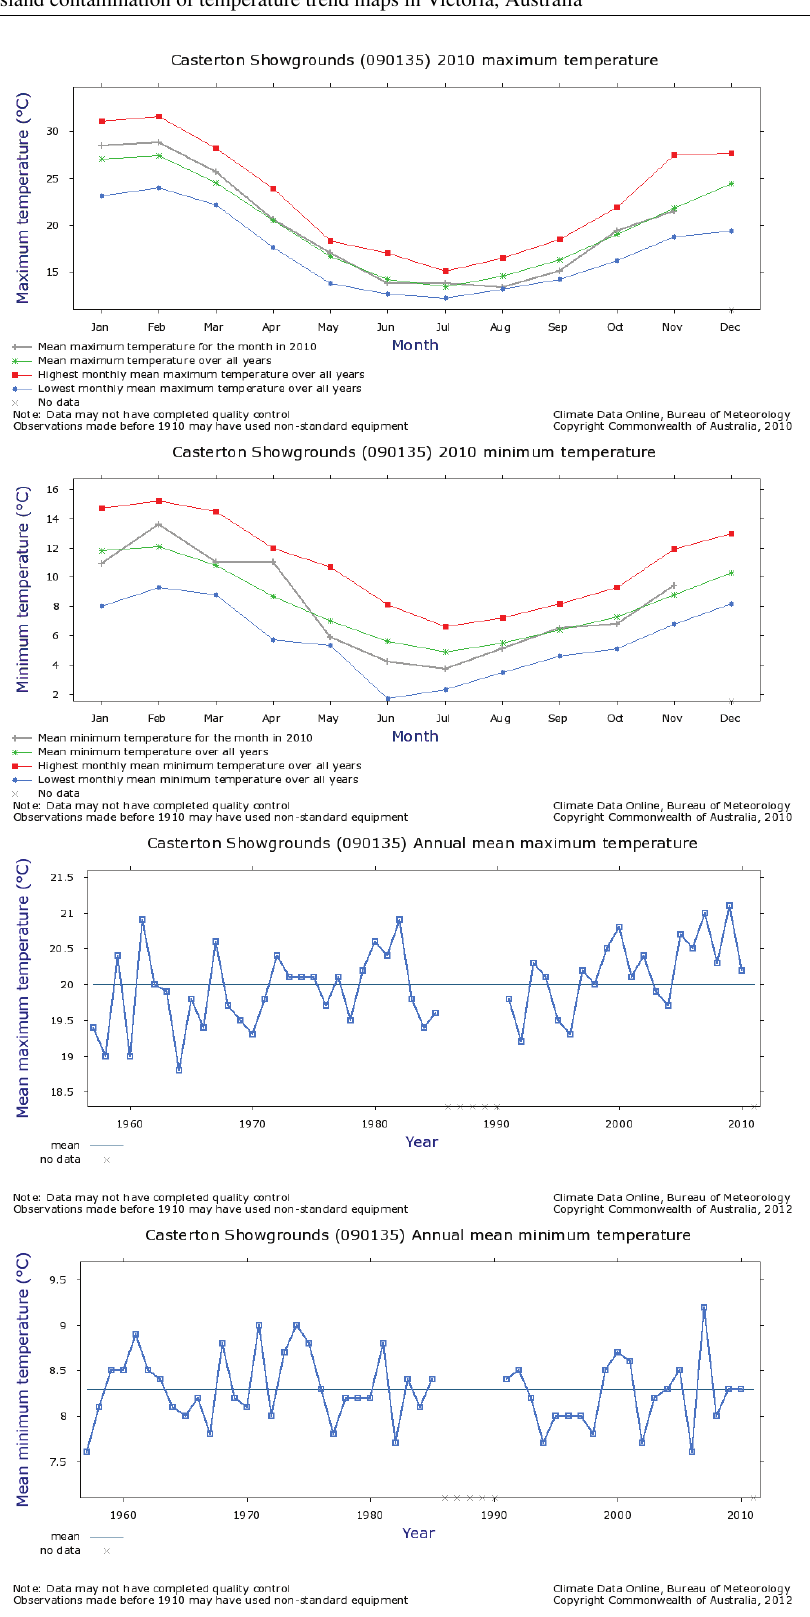
Figure 15. Australian Government Bureau of Meteorology temperature graphs for historical locations in Victoria, Aus- tralia. tion: 71